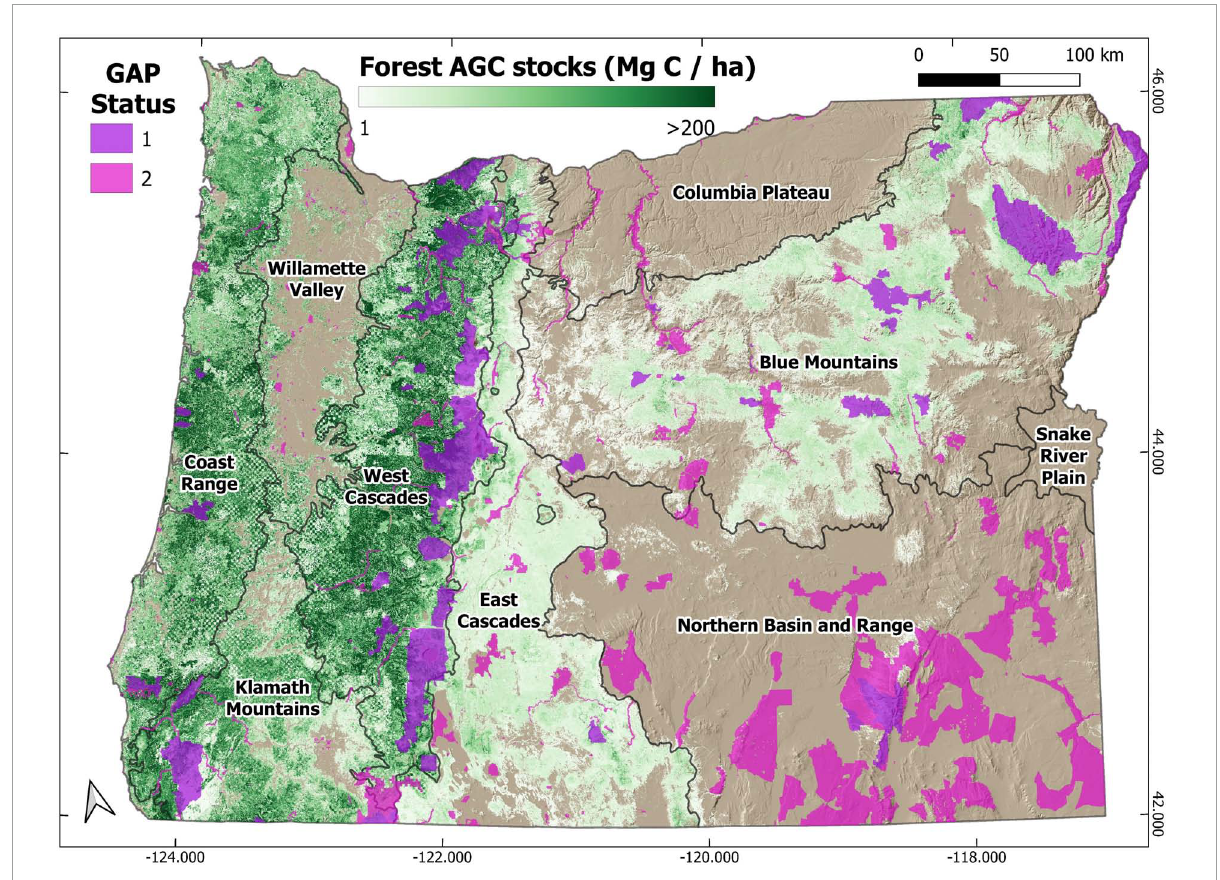
FIGURE1 Current protected lands and forest aboveground carbon stocks across Oregon. Protected lands depicted here are assigned GAP Analysis Project (GAP) Status 1 or 2 by the Protected Areas Database of the United States (PAD-US v. 2.1) (USGS GAP, 2020) and include both forestlands and non-forestlands. These statuses characterize areas with permanent protection from anthropogenic conversion of natural land cover. Forest aboveground carbon stocks (Mg C ha − 1 ) in 2017 were spatially modeled from inventory measurements, satellite remote sensing, and environmental data (Landscape Ecology Modeling Mapping and Analysis (Lemma) Team,